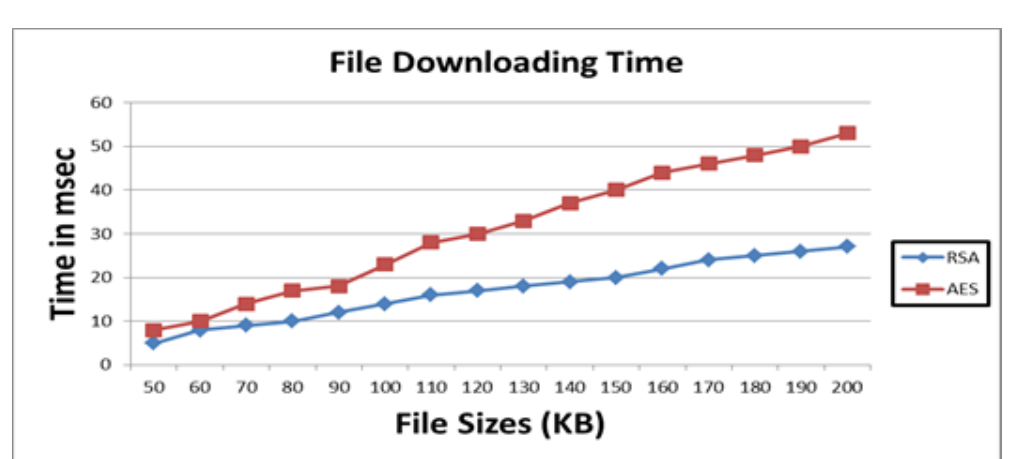
Figure 13 . File Downloading Time